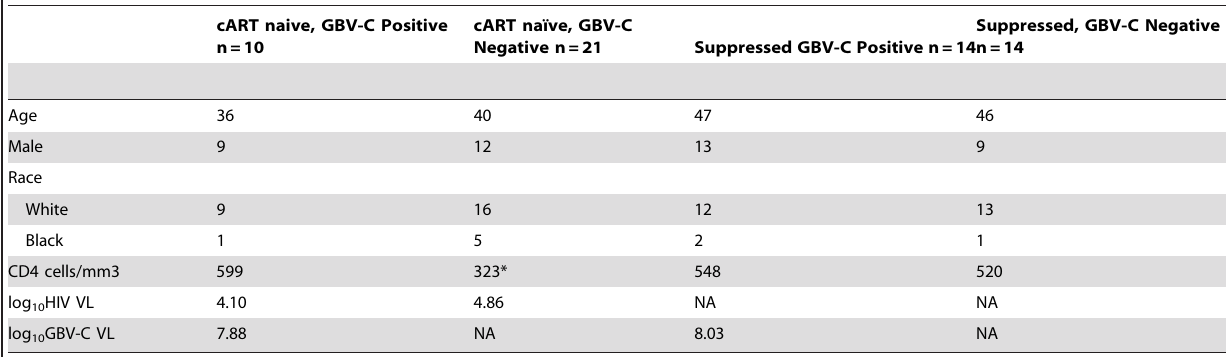
Table 1. Characteristics of study cohort.